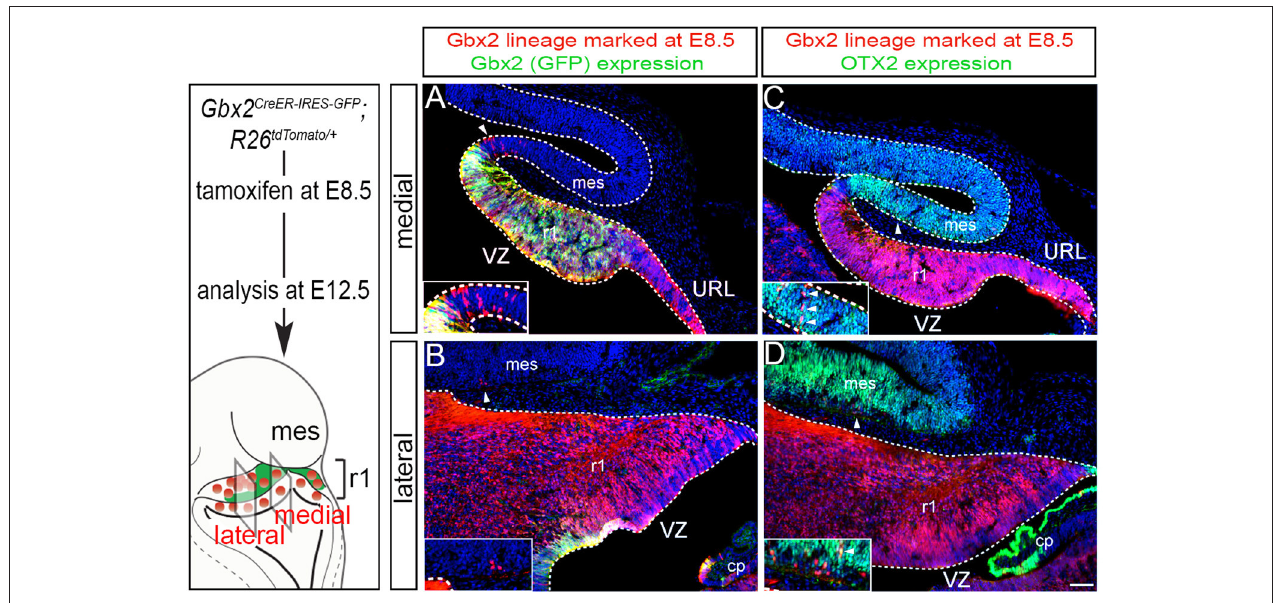
FIGURE 2 | Dynamic Gbx2 expression within the Gbx2 lineage in the Cb primordia. (A,B) Sections obtained from E12.5 Gbx2 CreER − IRES − EGFP / + ; Rosa26 tdTomato embryos. ICC was performed with an antibody recognizing tdTomato, which reveals the Gbx2 lineage marked at E8.5 (DsRed, red) concomitant with GFP labeling to reveal current Gbx2 expression (GFP, green). Note that Gbx2 expression was nearly absent in lateral r1 while Gbx2 expression was still present in medial sections with the exception of the posterior domain. (C,D) Sections adjacent to those shown in (A,B) were immunolabeled for tdTomato (DsRed, red) to identify the Gbx2 lineage and for OTX2 (green), which is a marker of the mes. Clones of the Gbx2 lineage were occasionally observed in the OTX2 + mes (arrowheads,